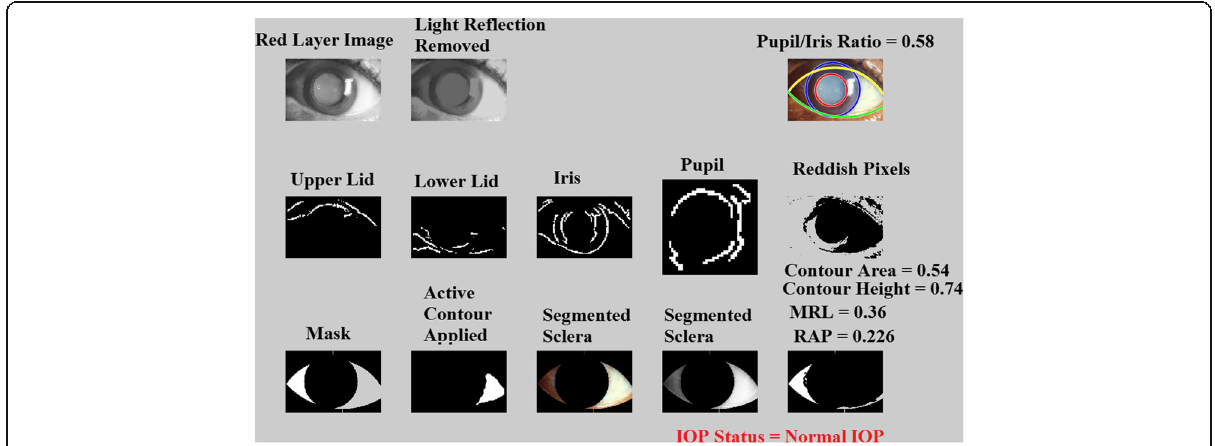
Fig. 15 Examples of normal IOP from additional frontal eye images from various races and ages with eye diseases/conditions other than high IOP (e.g., cataract, eye redness, and